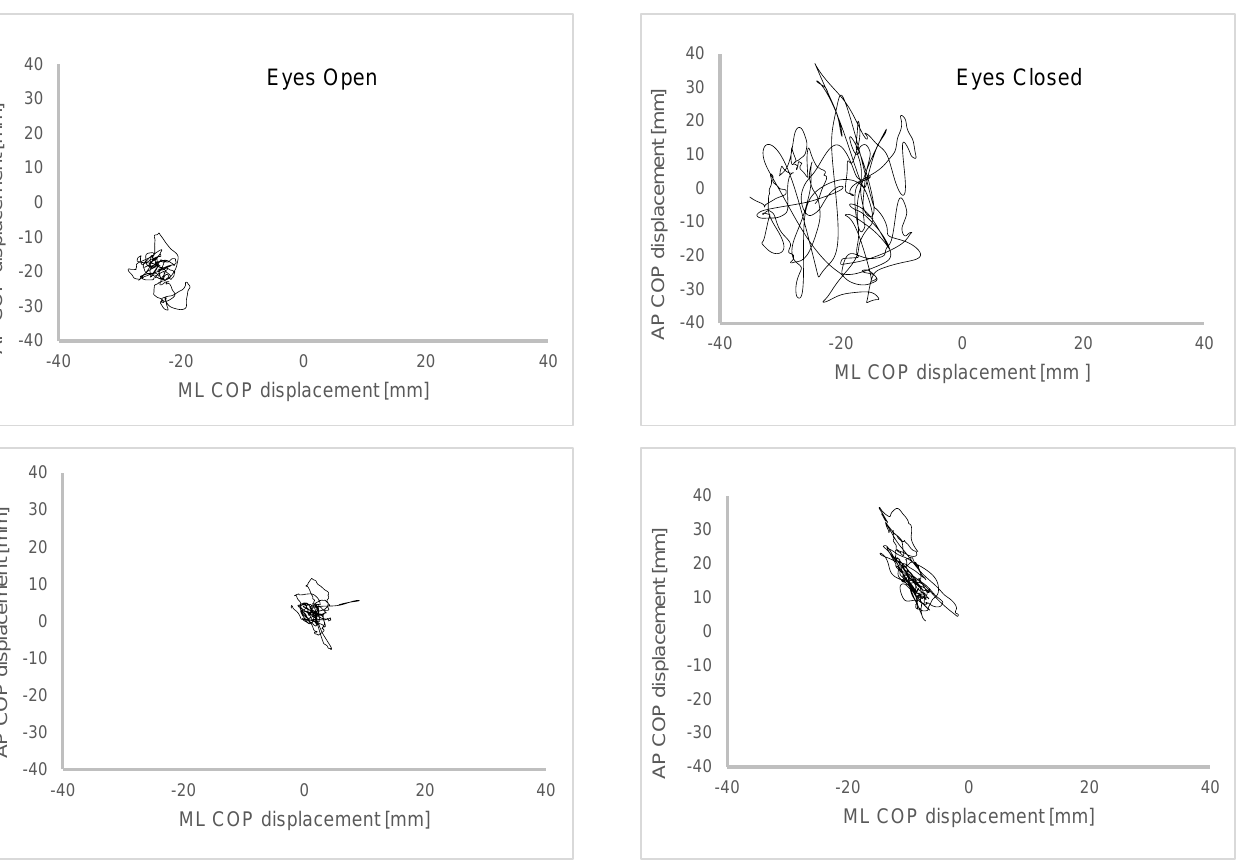
Figure 4: Examples of COP sway of one K1/2-participant compared to one classified as K4 in the eyes open and eyes closed